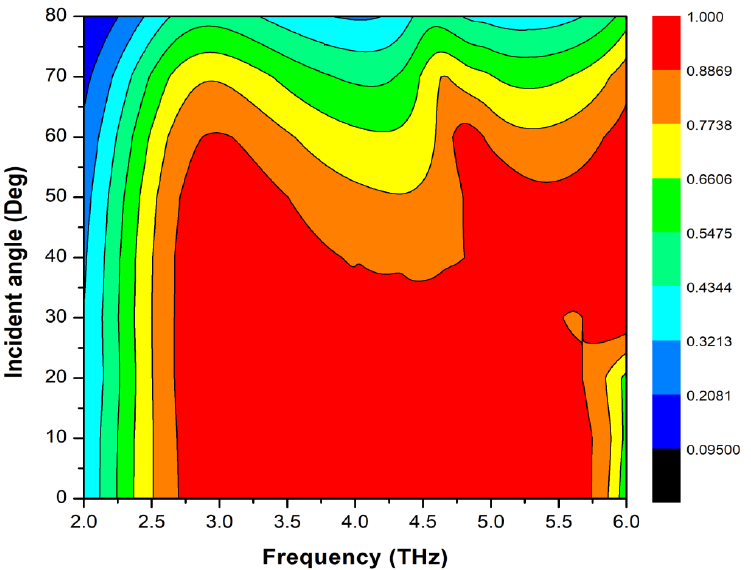
Figure 13. Incidence angle dependence of absorption phenomenon for TE polarization when σ = 20 × 10 4 S/m.